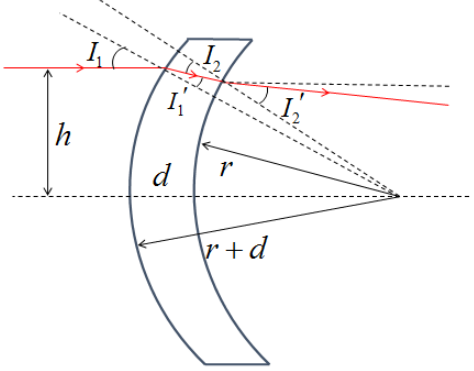
Figure B1. Light ray tracing model of the dome.